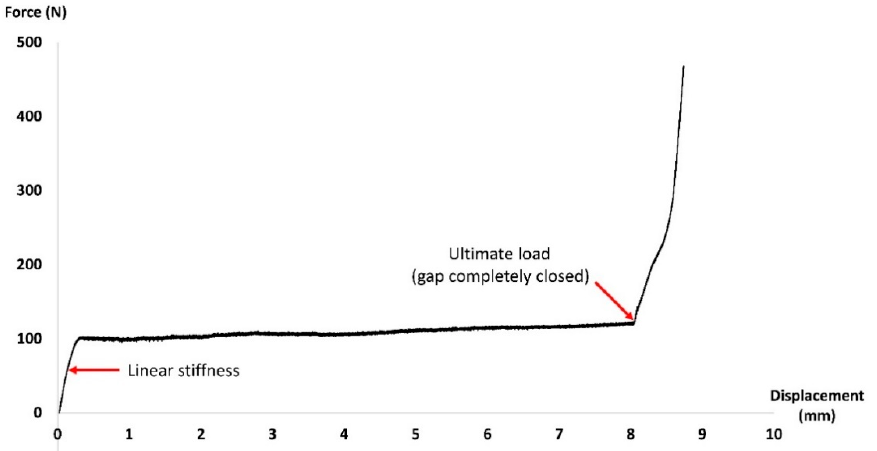
Figure 4. Relationship between the displacement and applied force of the sawbone with nails.